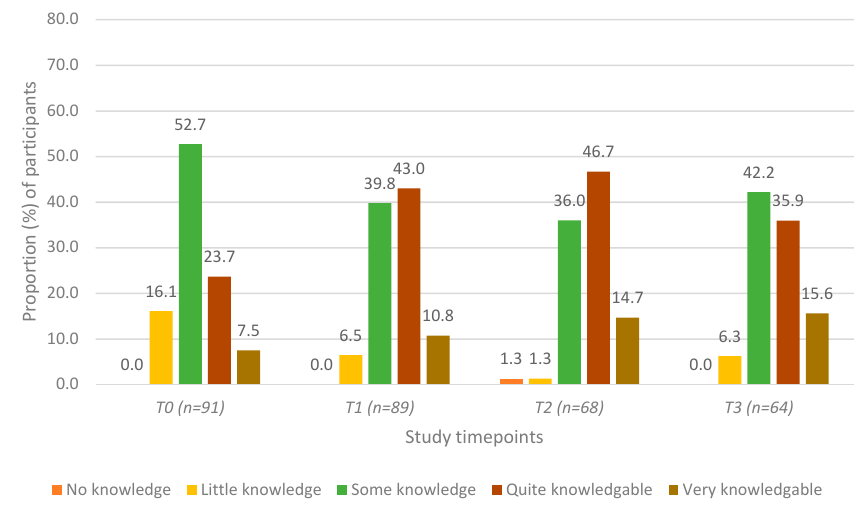
Figure 1. Self-reported level of general mental health knowledge among agricultural community members in Ontario, Canada at four timepoints: pre-training (T0), post-training (T1), 3 months post-training (T2), and 6 months post-training (T3).